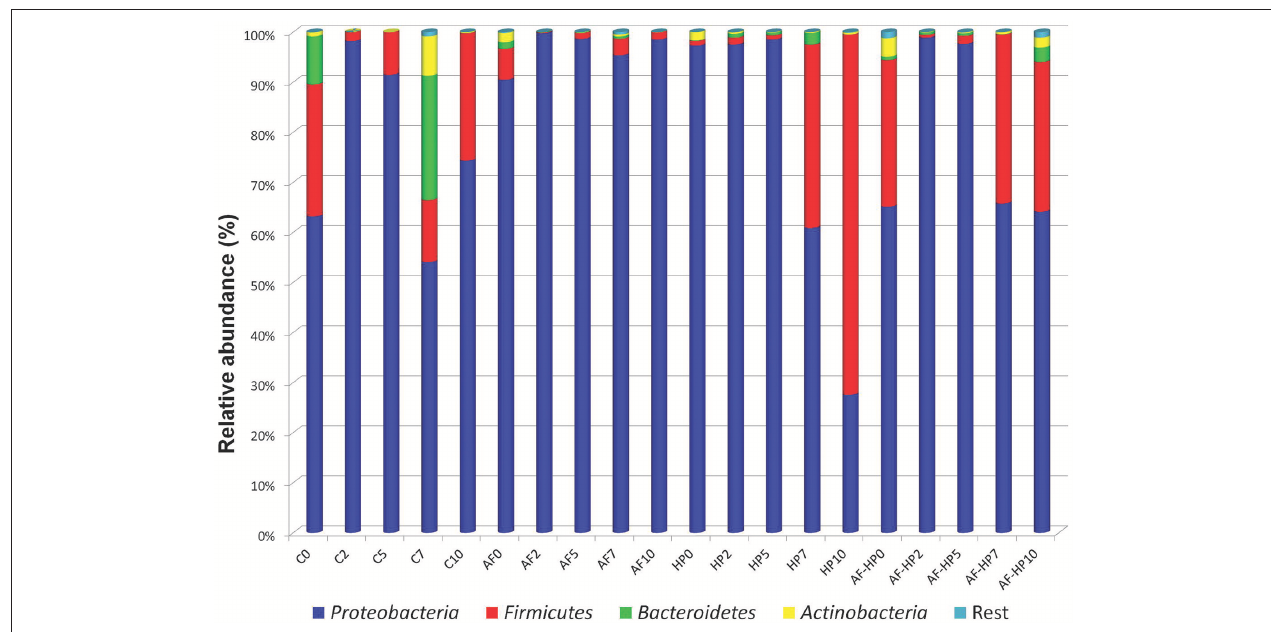
FIGURE 1 | Relative abundance of OTUs based on paired-end 16S rRNA gene sequencing analysis of DNA from refrigerated sea bream fillets. Controls packed in films without activation with antimicrobials (C); samples packed in films activated with thymol plus enterocin AS-48 (AF); samples packed in films without activation and treated by high-hydrostatic pressure (HP); samples packed in activated films and treated by high-hydrostatic pressure (AF-HP). Sampling was performed at days 0, 2, 5, 7, and 10. OTUs were grouped at Phylum